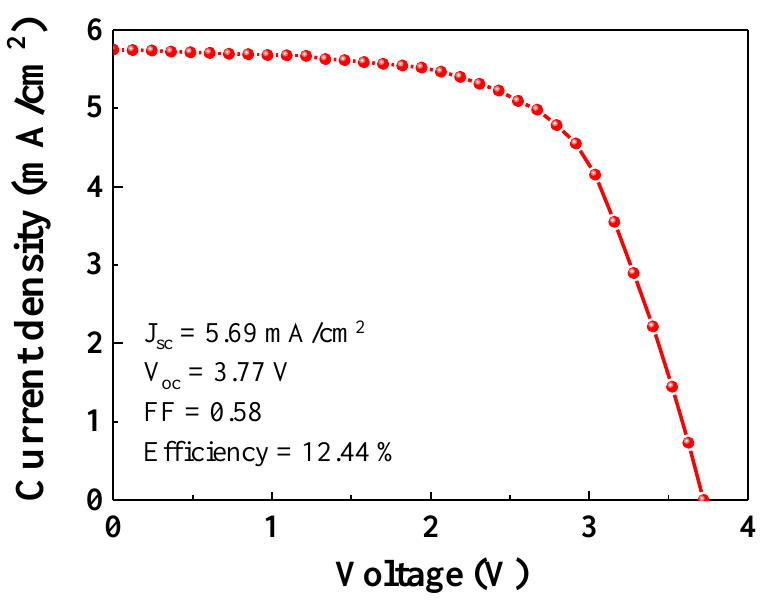
Figure 7. J-V curve for the integrated PSC unit, comprising four single PSCs connected in series.